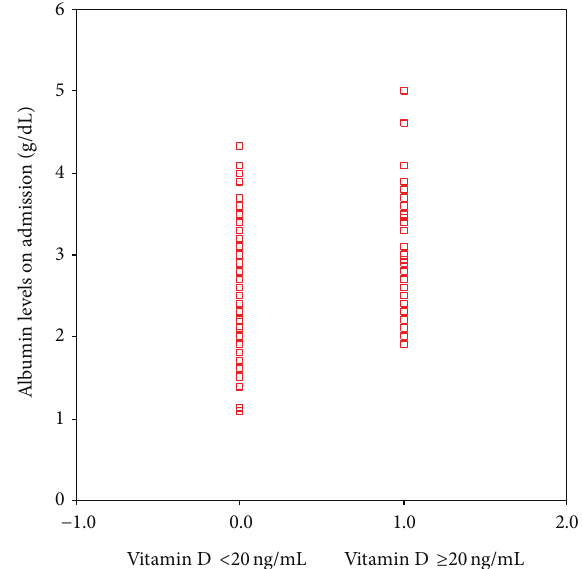
Figure 4: SOFA scores of vitamin D sufficient and insufficient groups (𝑃 = 0.005) .